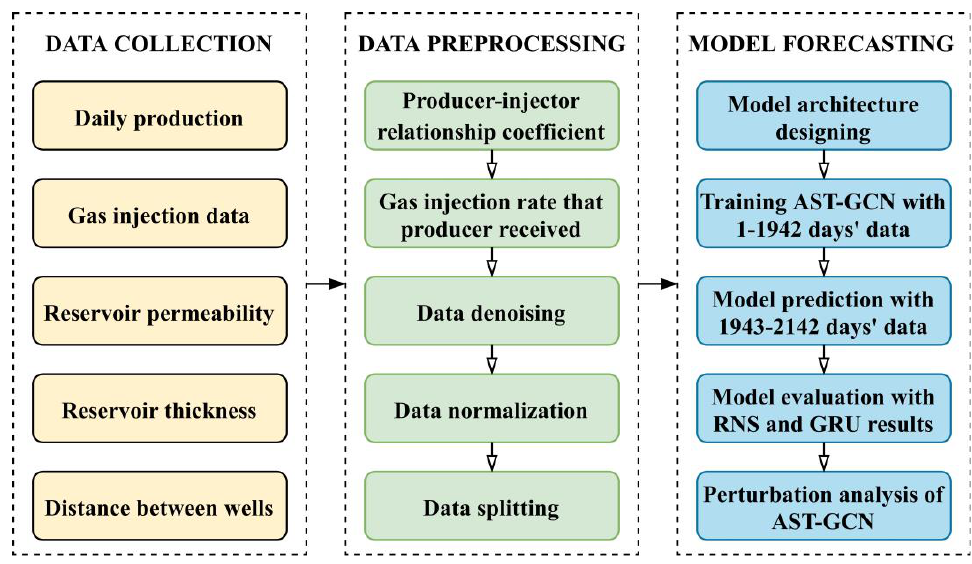
Figure 5. Workflow of our proposed method.